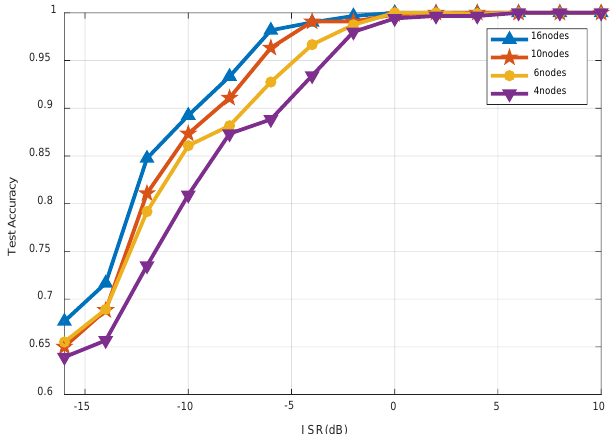
Figure 9. Performance comparison of hard-fusion based methods under a different number of nodes. Experiment 3: Performance comparison of jamming recognition for a different number of nodes in the soft-fusion based method.